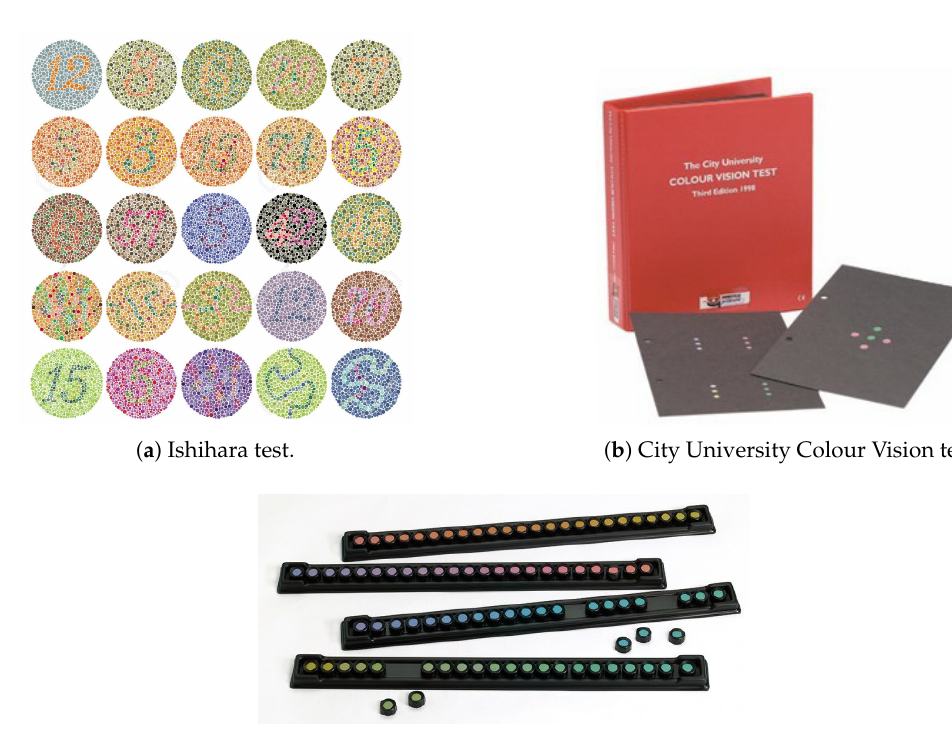
Figure 4. Color vision